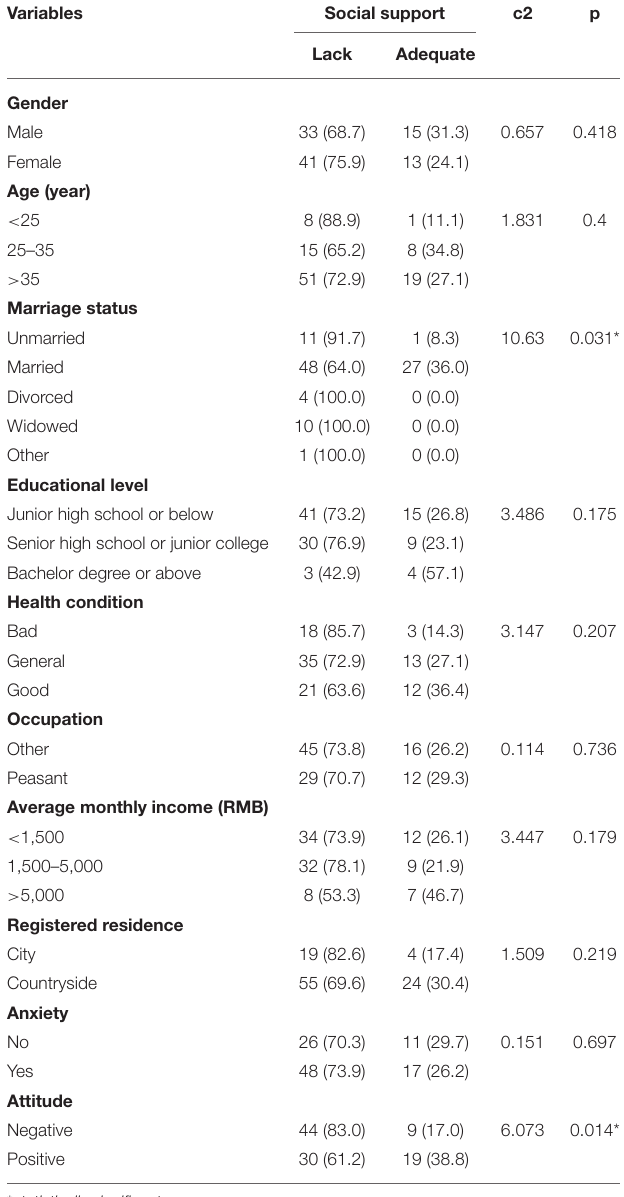
TABLE 7 | Analysis on influencing factors of social support level of organ donor’s family